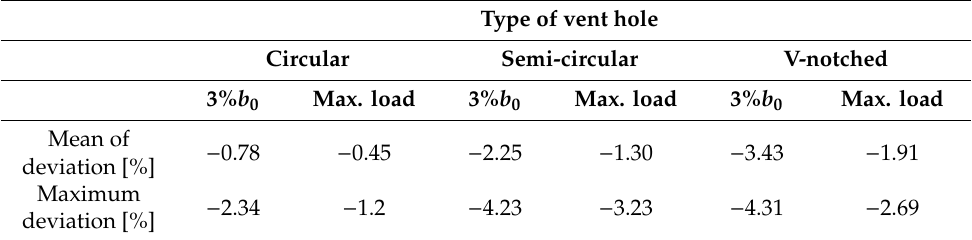
Table 6. Deviations of loads for di ff erent vent holes with respect to joints without holes. Type of vent hole Circular Semi-circular V-notched 3% b 0 Max.